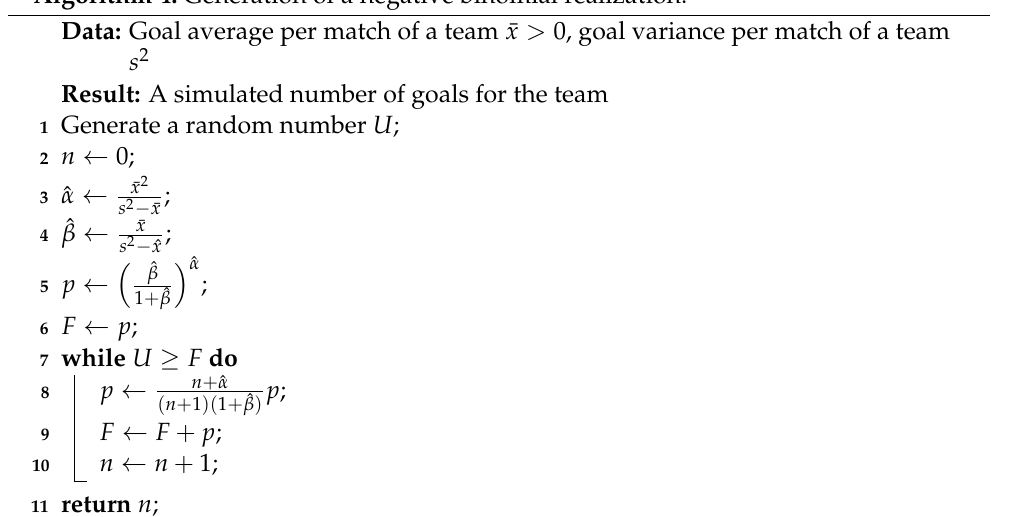
Algorithm 4: Generation of a negative binomial